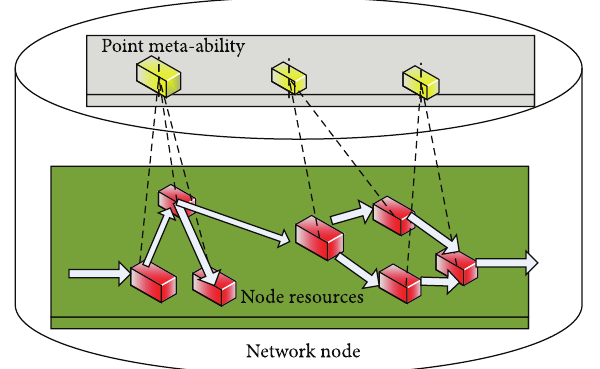
Figure 3: The reconfiguration mechanism of point